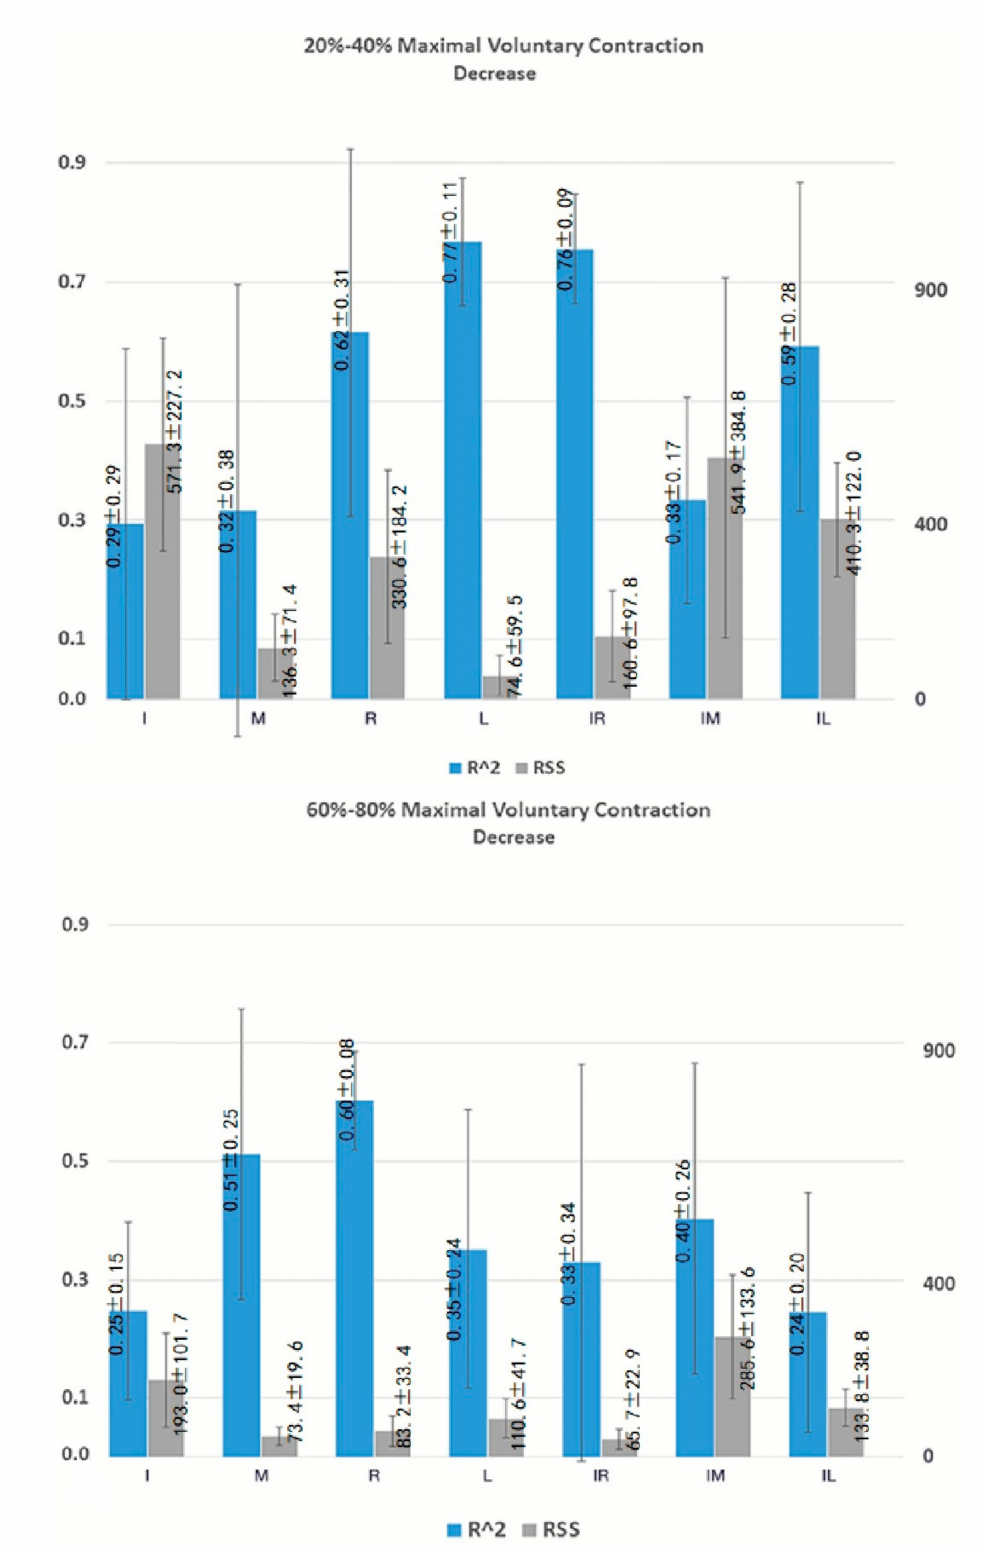
Figure 5. R 2 and residual sum of squares (RSS) of individual fingers and paired fingers, R 2 refers to the left vertical axis; the residual sum of squares refers to the right vertical